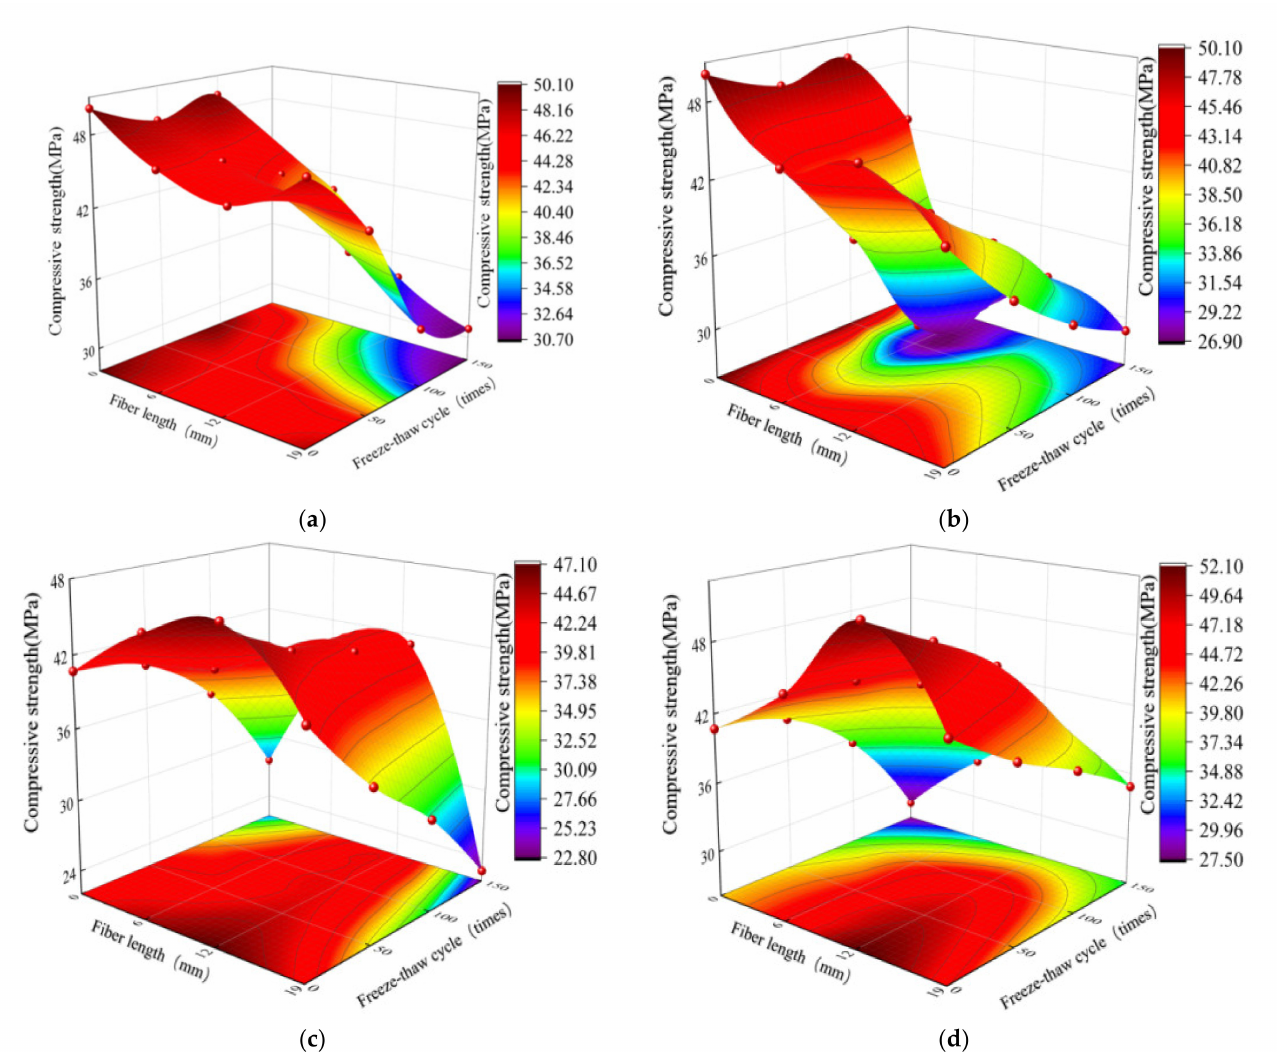
Figure 4. Compressive strength test value at different freeze–thaw cycles: ( a ) PFMSC compressive strength value when PPF volume is 1.0%, ( b ) PFMSC compressive strength value when PPF volume is 1.2%, ( c ) PFNSC compressive strength value when PPF volume is 1.0%, ( d ) PFNSC compressive strength value when PPF volume is